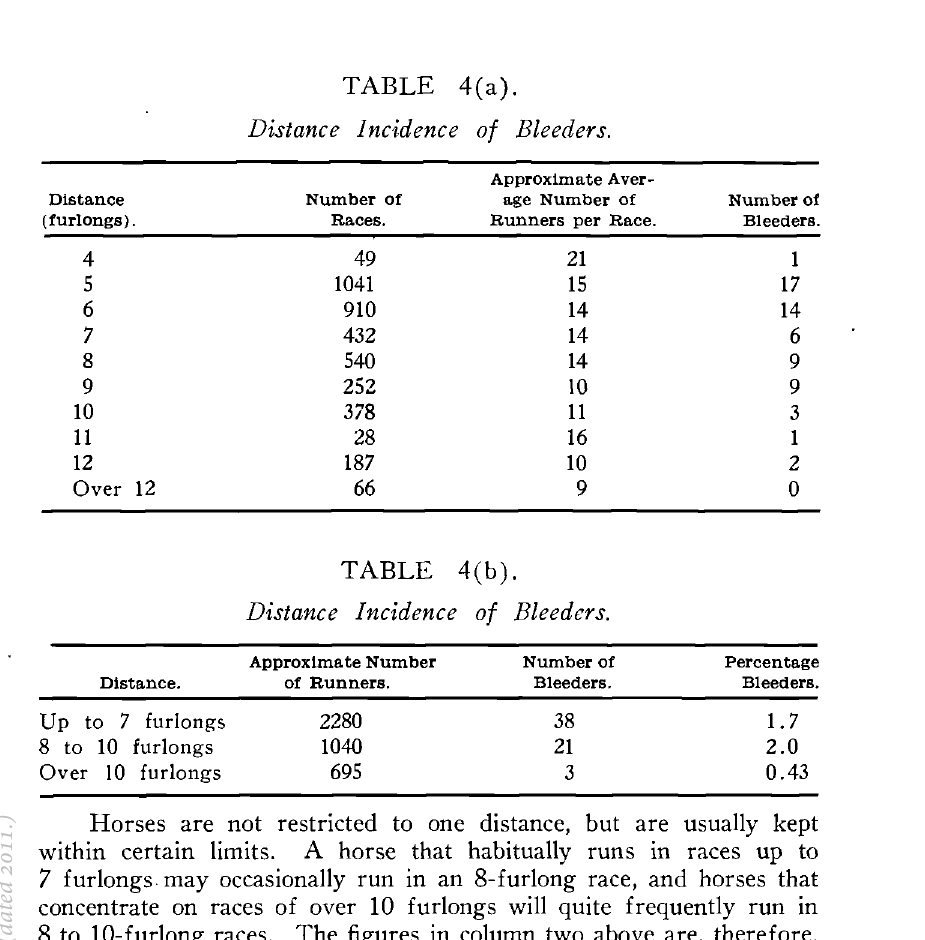
Seasonal Incidence of Bleeders. Number of